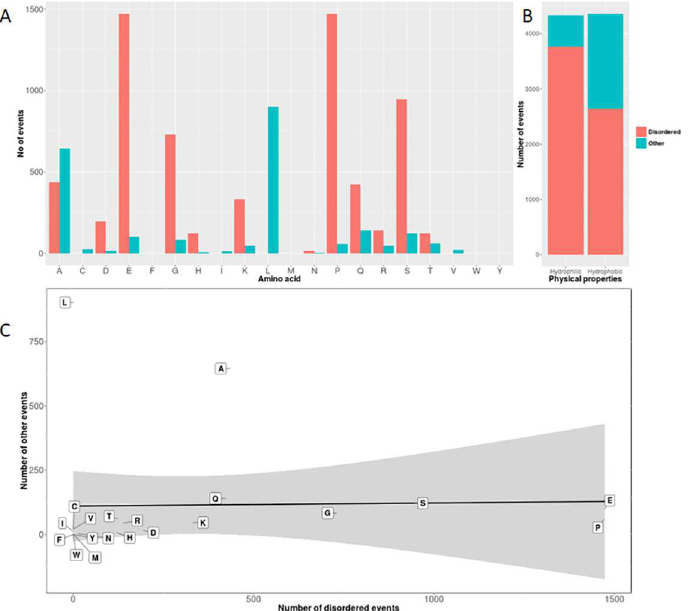
Fig 4. Disordered and regular domains in the human proteom. (A) SAARs were categorized basedon their presencein the regularor disorderedregionof the protein, annotated using the D2P2.prodatabase. The X-axis denotes each of the 20 different amino acids and the Y-axis shows the numberof SAAR events in the disordered and regularpart of proteinsin the humanproteome. (B) A stacked bar plot shows the number of events in the disordered regionof the protein (red) and the regular region(blue) categorized based on the amino acids’ physical properties. (C) Scatter plot with linear regression analysisfor each amino acid showing the numberof SAAR events in the disordered regions (X-axis) vs. SAAR events in the other regions(Y-axis). Grey shadedarea indicates95%